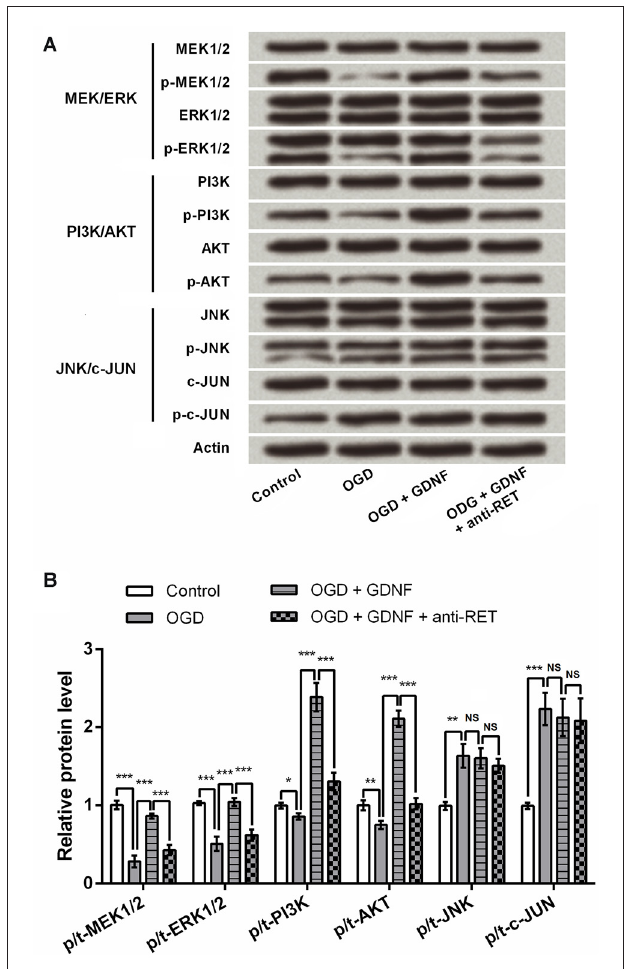
FIGURE 5 | GDNF regulates the mitogen-activated protein kinase (MAPK) kinase (MEK)/ERK and phosphoinositide-3-kinase (PI3K)/v-akt murine thymoma viral oncogene homolog (AKT) signaling pathways, but not the JNK/c-JUN pathway. Actin is used as an internal control. (A) The phosphorylated forms of MEK1/2, ERK1/2, PI3K and AKT (p-MEK1/2, p-ERK1/2, p-PI3K and p-AKT) are promoted by GDNF and suppressed by anti-RET antibody treatment. The phosphorylated forms of JNK and c-JUN (p-JNK or p-c-JUN) are barely changed by GDNF or anti-RET antibody treatment. (B) Relative protein levels based on Western blot results. NS, not significant. ∗ P < 0.05. ∗∗ P < 0.01. ∗∗∗ P <